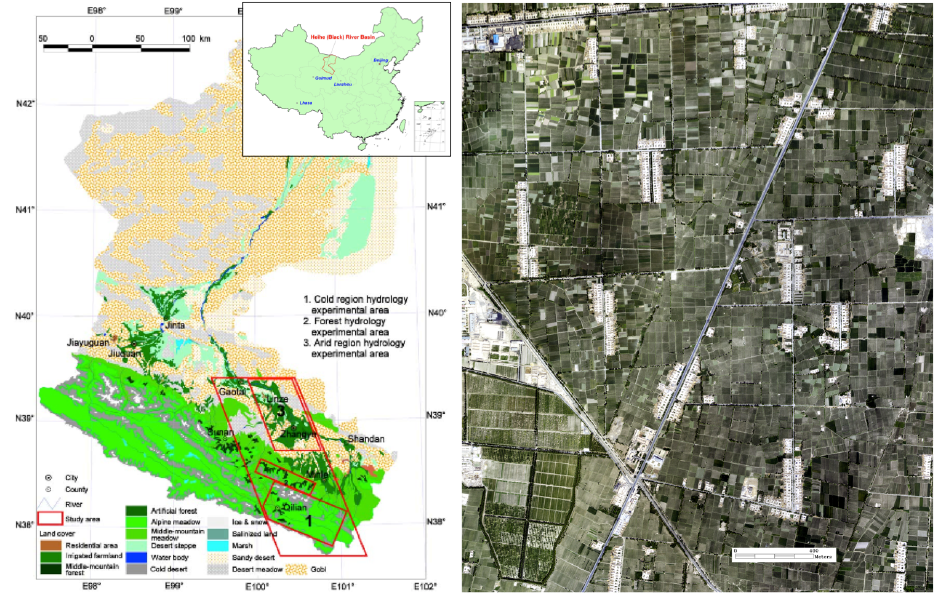
Figure 1: (left) location of the HeiHe River Basin in the People’s Republic of China and location of the three experimental areas within the basin (Source: Li et al 2009); (right) detailed view of the Yingke Oasis. The extent of this scene is the same as the coverage of the LIDAR data, i.e. 7.2km 2 . This image and the LIDAR data were acquired simultaneously, using a CCD camera onboard the aircraft.